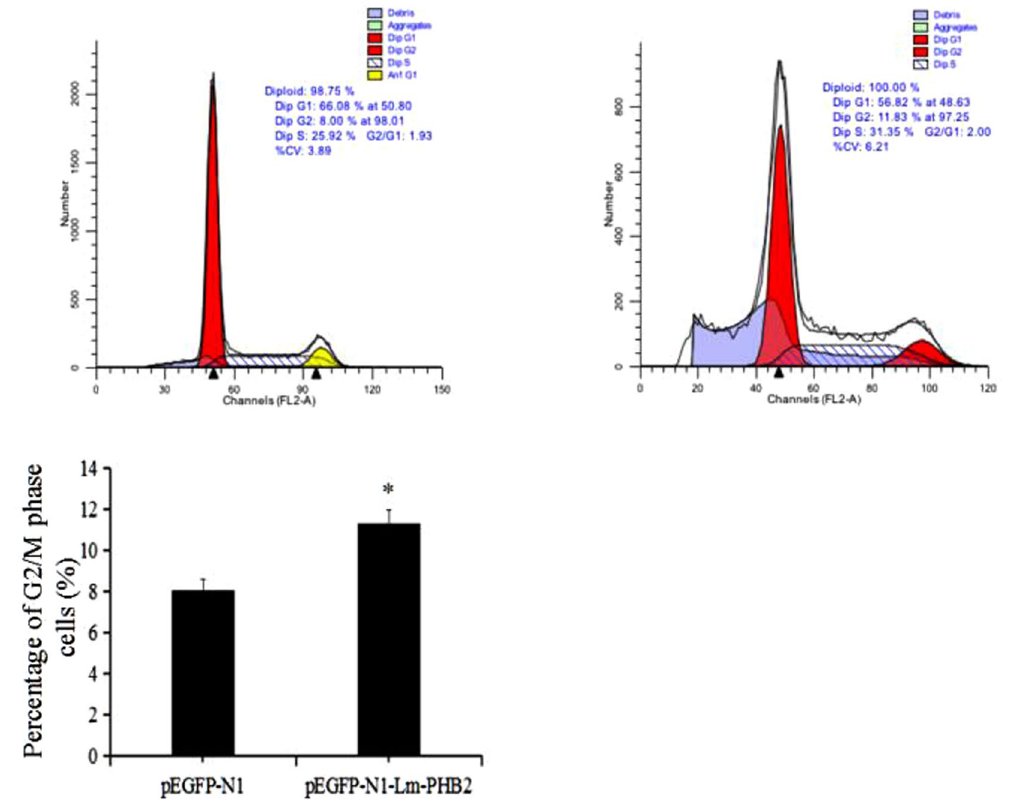
Figure 4. Effects of Lm-PHB2 on the proportion of cells in different phases of the cell cycle. HeLa cells were transfected with pEGFP-N1 or pEGFP-N1-Lm-PHB2 at 37 °C for 36 h followed by PI staining and flow cytometry analysis. The histogram shows the percentage of G2/M phase cells in both groups. Data are the means ± SDs from three experiments. ‘ * ’ indicates significantly different from PBS-treated cells at the P < 0.05